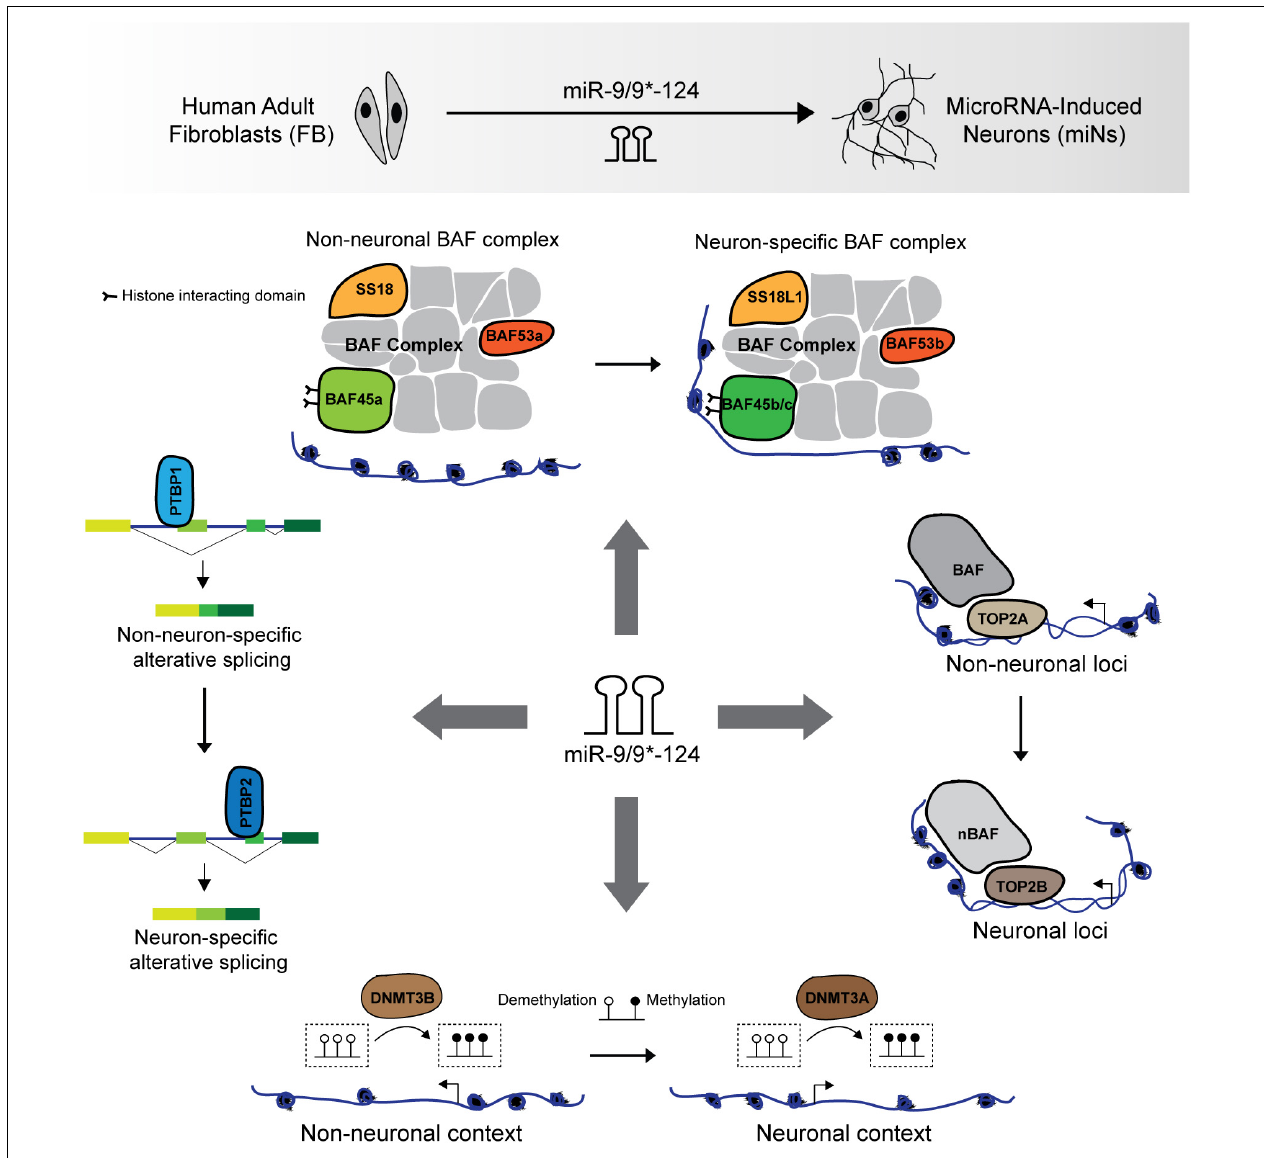
FIGURE 1 | MiR-9/9 ∗ -124-mediated neuronal reprogramming of human adult fibroblasts. Ectopic expression of miR-9/9 ∗ -124 in human adult fibroblasts leads to the switching of several non-neuronal to neuronal components for neural fate acquisition. MiRNAs orchestrate the genetic switching of epigenetic regulators including the BAF complex subunits (BAF53a, BAF45a, and SS18 to BAF53b, BAF45b/c, and SS18L1/CREST), TOP2A to TOP2B, and DNMT3B to DNMT3A. These coordinated molecular switches underlie the establishment of a neuronal epigenetic landscape during neuronal reprogramming. Additionally, the switching of PTB proteins, from PTBP1 to PTBP2, mediated by miR-124 activates neuron-specific alternative splicing program.